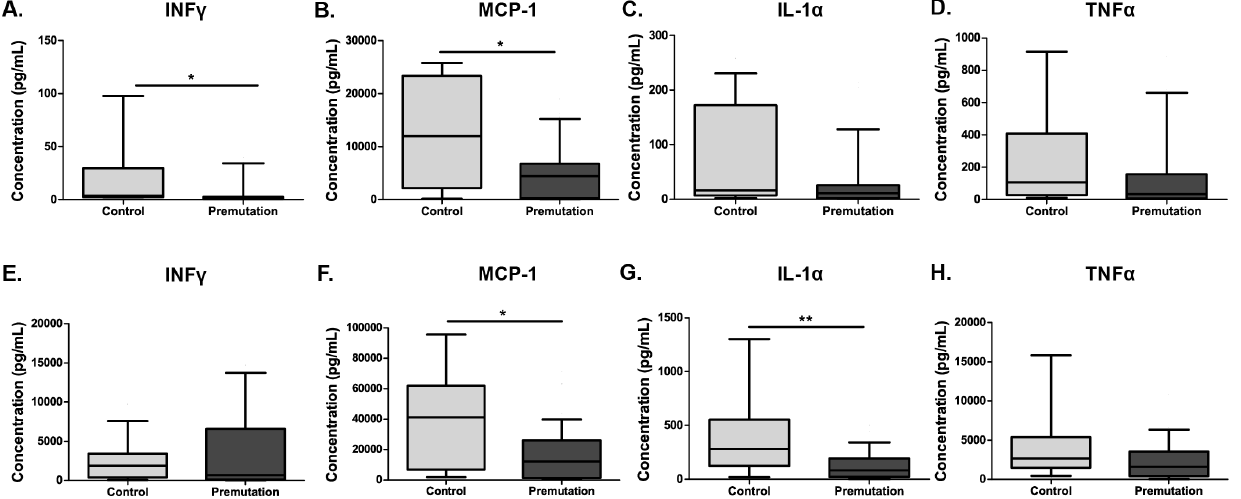
Figure 2. Cytokine production in human PBLs. PBLs from premutation carriers showed significantly decreased production of ( A ) IFN c and ( B ) MCP-1; however, no apparent differences were seen in ( C ) IL-1 a and ( D ) TNF a when cultured in media alone. When stimulated with a PHA, decreased production of ( E ) IFN c in premutation carriers was seen and difference in ( F ) MCP-1 remained. Both (G) IL-1 a and ( H ) TNF a showed trends towards decreased production, but did not reach significance. *p , 0.05, and **p ,